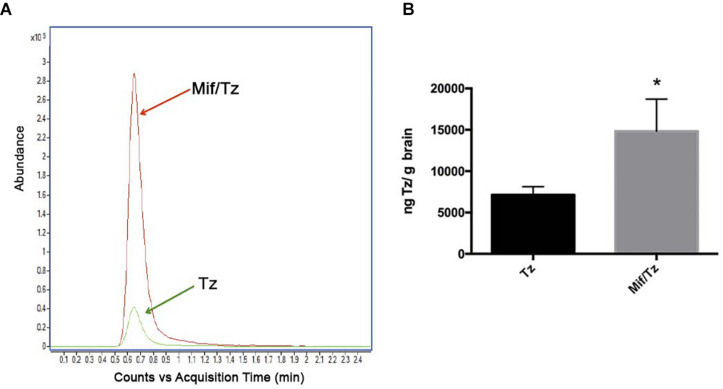
(A) Based on typical chromatograms of temozolomide in brain tissue, there was a significantly higher concentration of temozolomide (Tz) in rats given a pre-treatment of 60 mg/kg of mifepristone (Mif) followed by 30 mg/kg of Tz (red line) than in animals receiving only 30 mg/kg of Tz (green line). (B) Bar graph illustration of the Tz uptake in rat brain tissue (n = 6 ± SD). *Significant difference (p < 0.05).